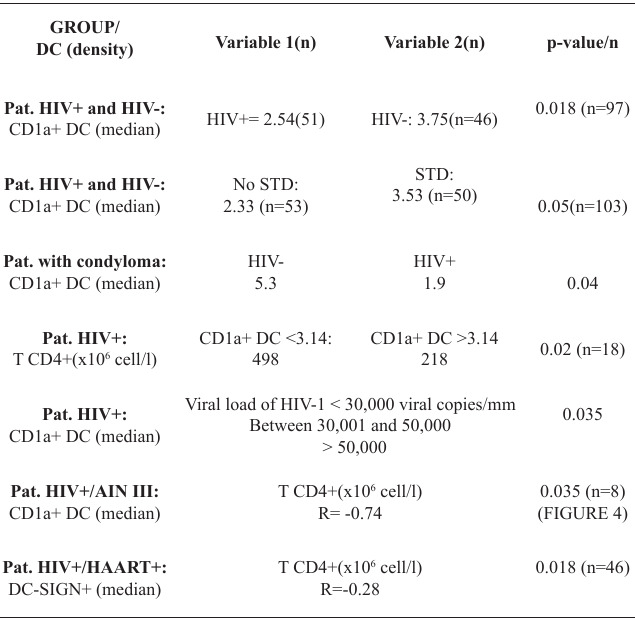
TABLE 1 - Significant findings involving dendritic